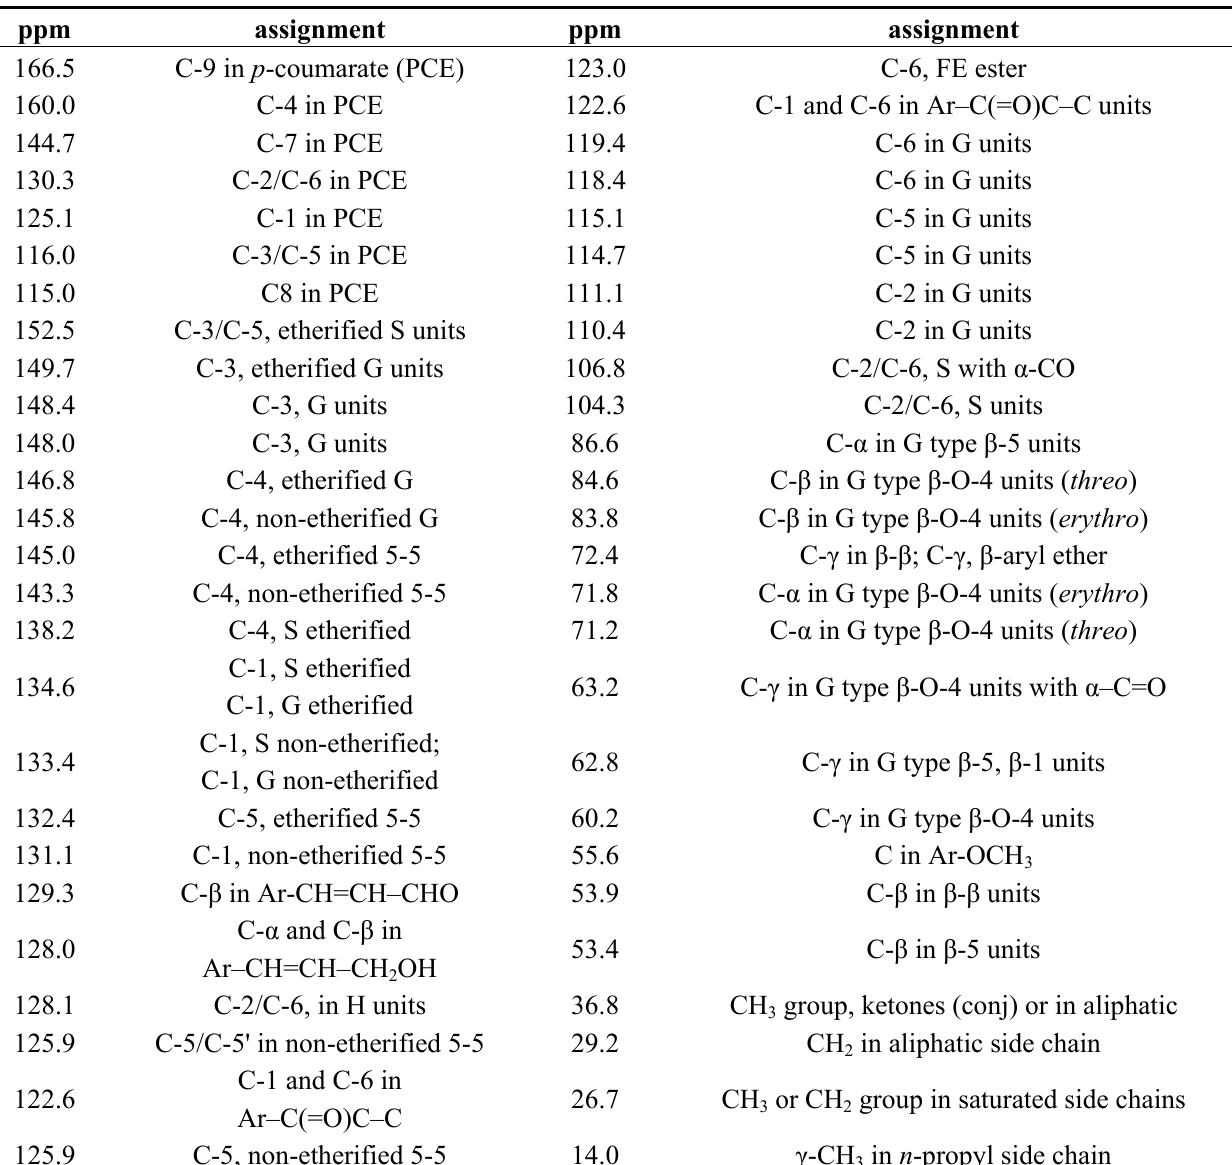
Table 1. The chemical shift v alue (δ, ppm) of 13 C-NMR spectrum of non-acetylated